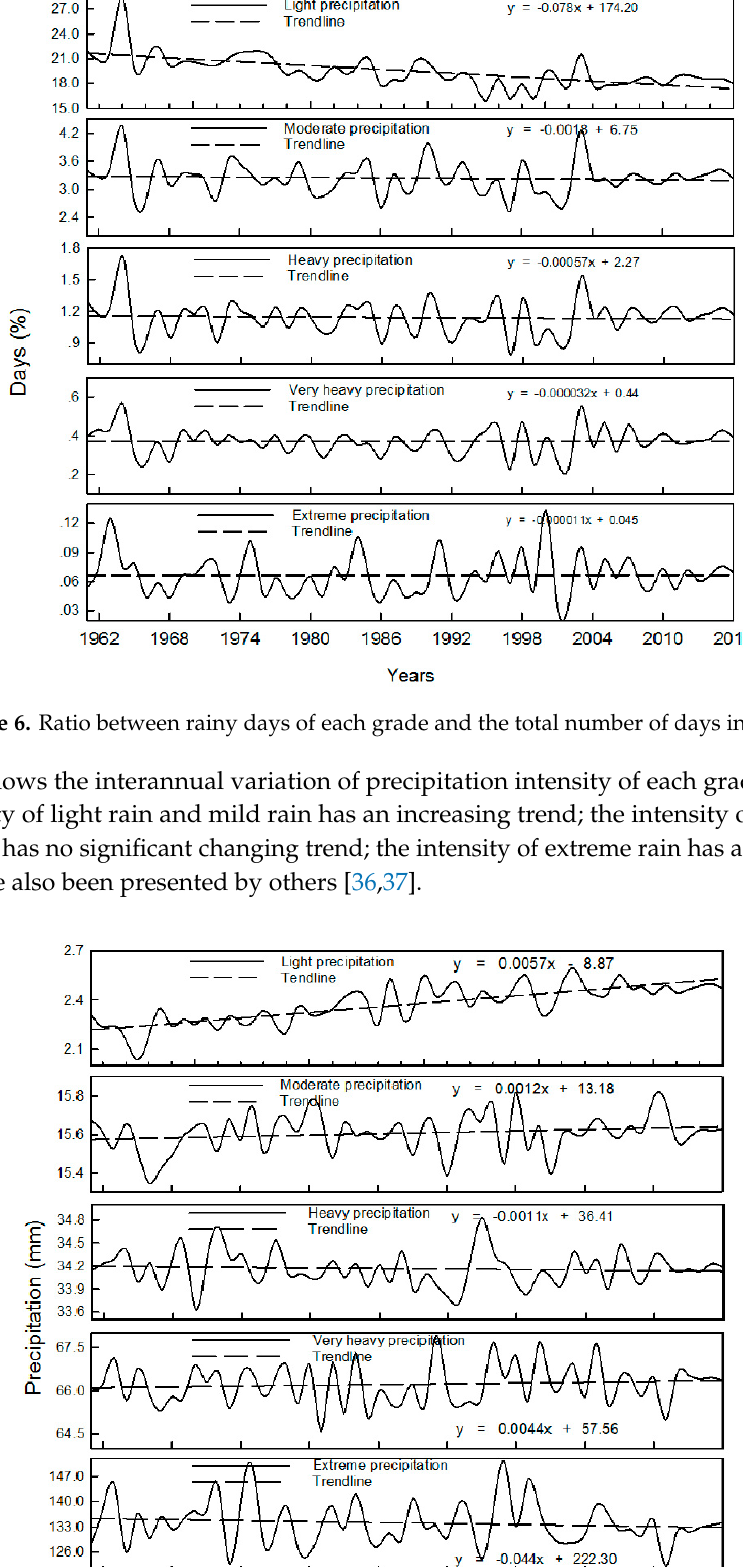
Figure 7. Interannual variation of precipitation intensity of each grade.